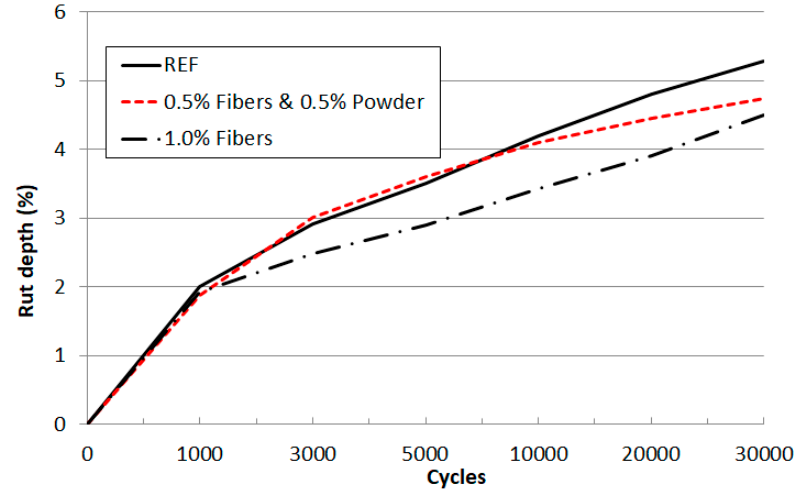
Figure 17. Examples of wheel tracking tests (50 °C).